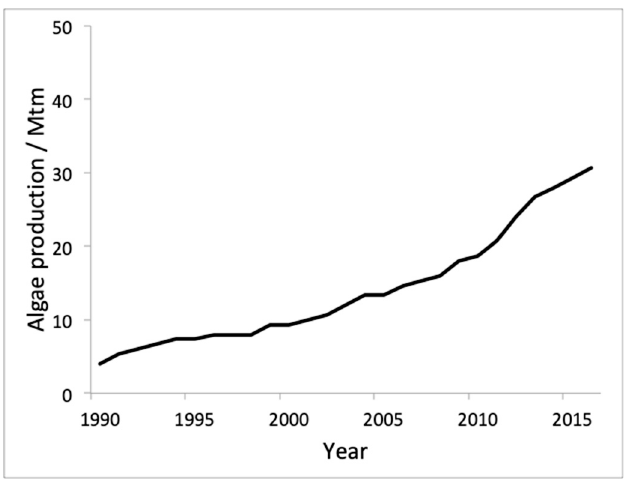
Figure 6. ( a ) Distribution by continents of world aquiculture production (2017) (Source: FAO [31,164– 166]) and ( b ) production of the 10 leading aquatic producers in the world (2017) (Source: FAO [31,164– 166]).